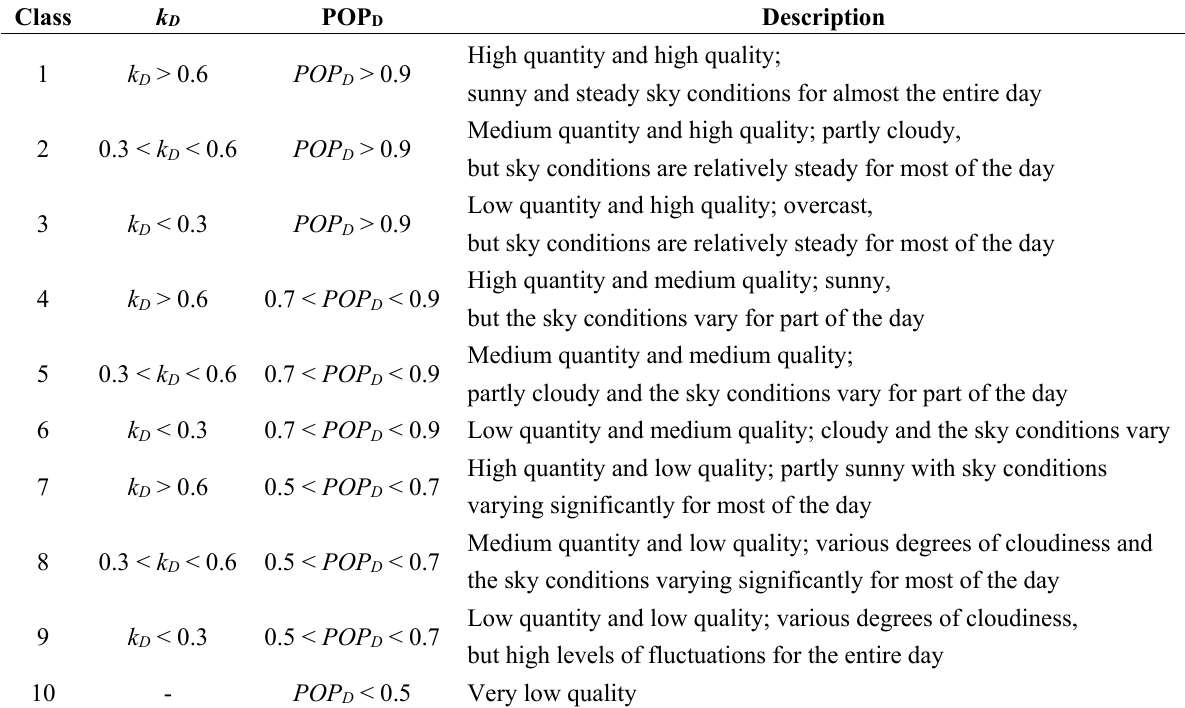
Table 1. Classification parameters of solar radiation with k D and POP D